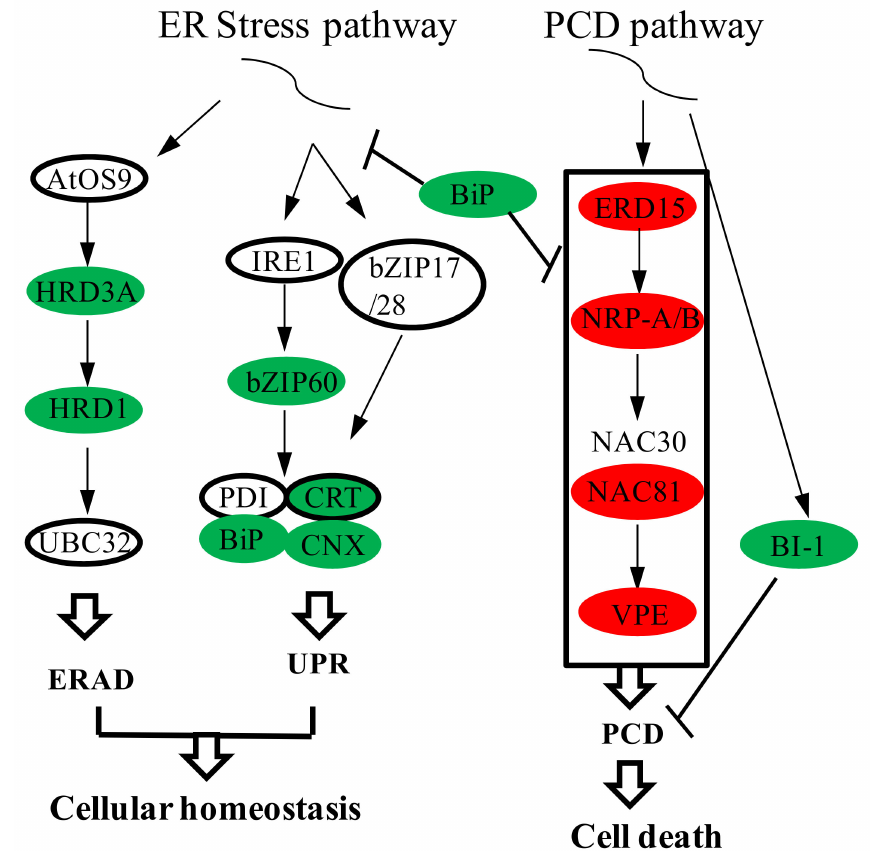
Figure 5. Gene expression in ER stress and PCD pathway. ER: endoplasmic reticulum; ERAD: ER-assisted degradation; UPR: Unfolded protein response; PCD: programmed cell death; BiP: binding protein; IRE1: inositol-requiring enzyme 1; PDI: protein disulfide isomerase; CRT: calreticulin; CNX: calnexin; VPE: vacuolar processing enzyme; BI-1:Bax inhibitor 1 gene; NRP: N-rich protein. Red indicates upregulated expression, and green indicates downregulated